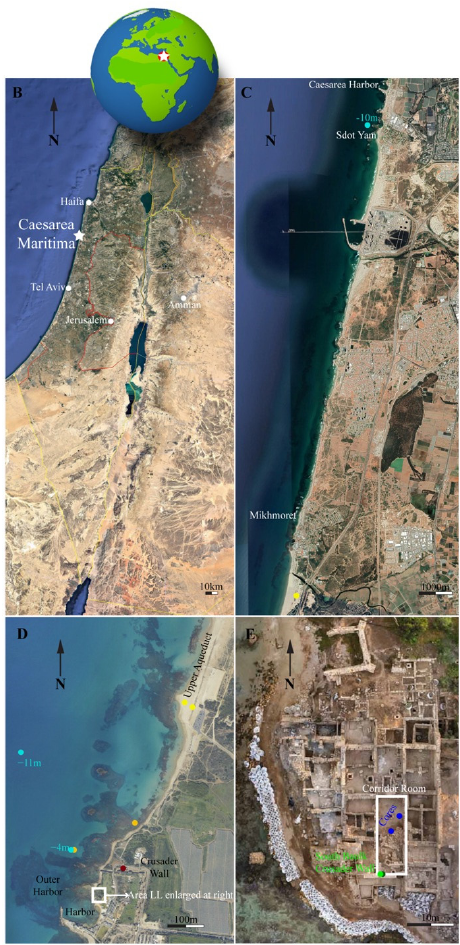
Figure 1. Location and aerial photographs of Caesarea Maritima. All colored dots are linked to locations where samples were taken. ( A ) Location of the study site. Shaded region shows zone of intense damage from the 749 CE earthquake [45]. ( B ) Map of Israel with Caesarea Maritima marked along the coast. ( C ) Map of the coastal study region. ( D ) Aerial view of the archaeological site and southern part of the Upper aqueduct, where reference samples were collected (See Table 1 for color legend.). ( E ) Aerial view of Area LL, bordering the northern side of the inner harbor basin. The blue dots indicate cores collected within the excavation layers, and the green dots mark the southern baulk adjacent to a later crusader wall (after [46]. The bolded white rectangle in E highlights the Corridor area of Area LL, the primary focus of the study. Table 1. Overall Comparison Table. Table comparing the anomalous sediment characteristics to each reference sediment type. For each parameter, sample values for each sediment type have been averaged. The anomalous samples are all shaded in black. For all reference sediments, the box for each parameter is shaded based on how distant (by %) it is from the anomalous sample values, which are shaded black. With each 5% difference away from the anomalous samples, the shading becomes lighter. White cells indicate a value that shares the least similarity while black or dark gray indicates closer similarity.